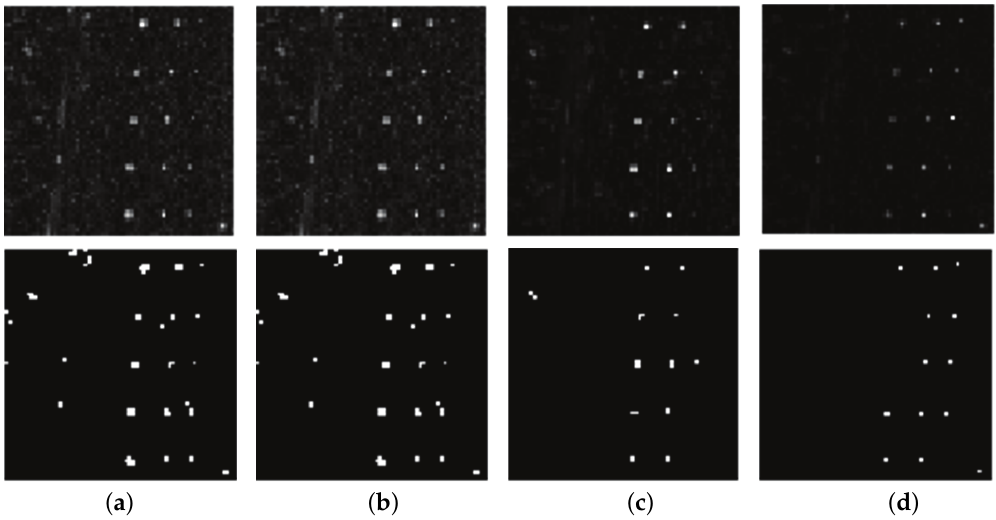
Figure 12. Detection results of HYDICE data for different algorithms: ( a ) LS-RXD; ( b ) R-LS-RXD; ( c ) R-BS-LS-RXD; ( d )